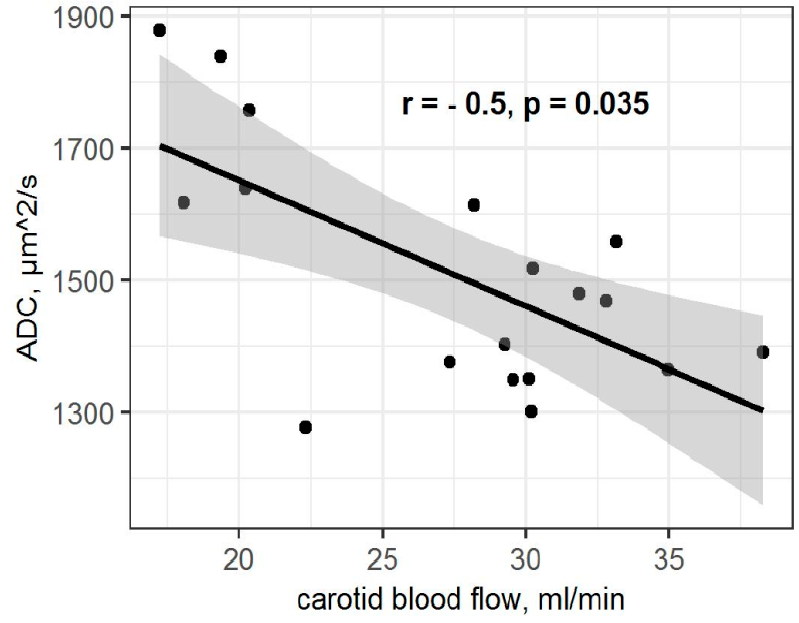
Figure 4. Spearman correlation between carotid blood flow rate and ADC values in PSS rats. Gray area around the line represents the 95% confidence interval.